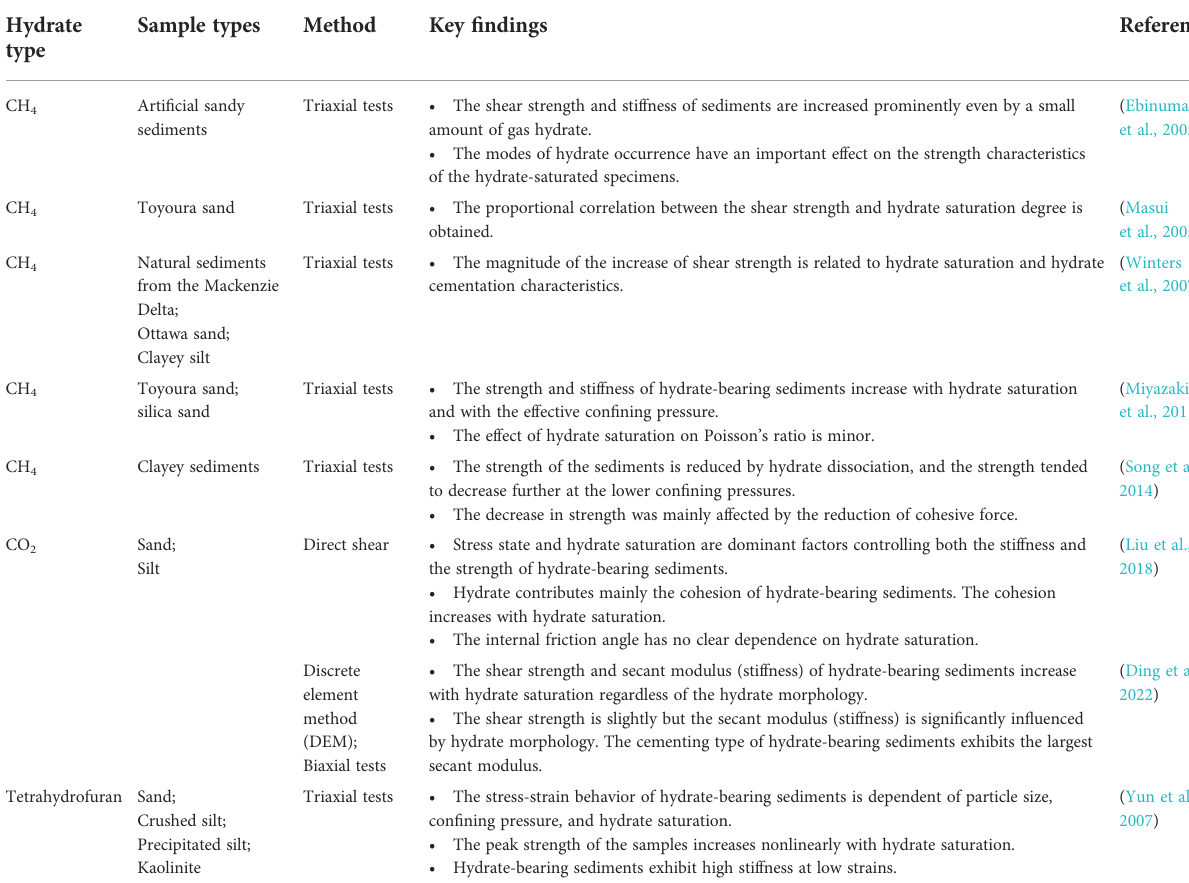
TABLE 3 Summary of experimental or numerical tests on geomechanical properties of hydrate-bearing